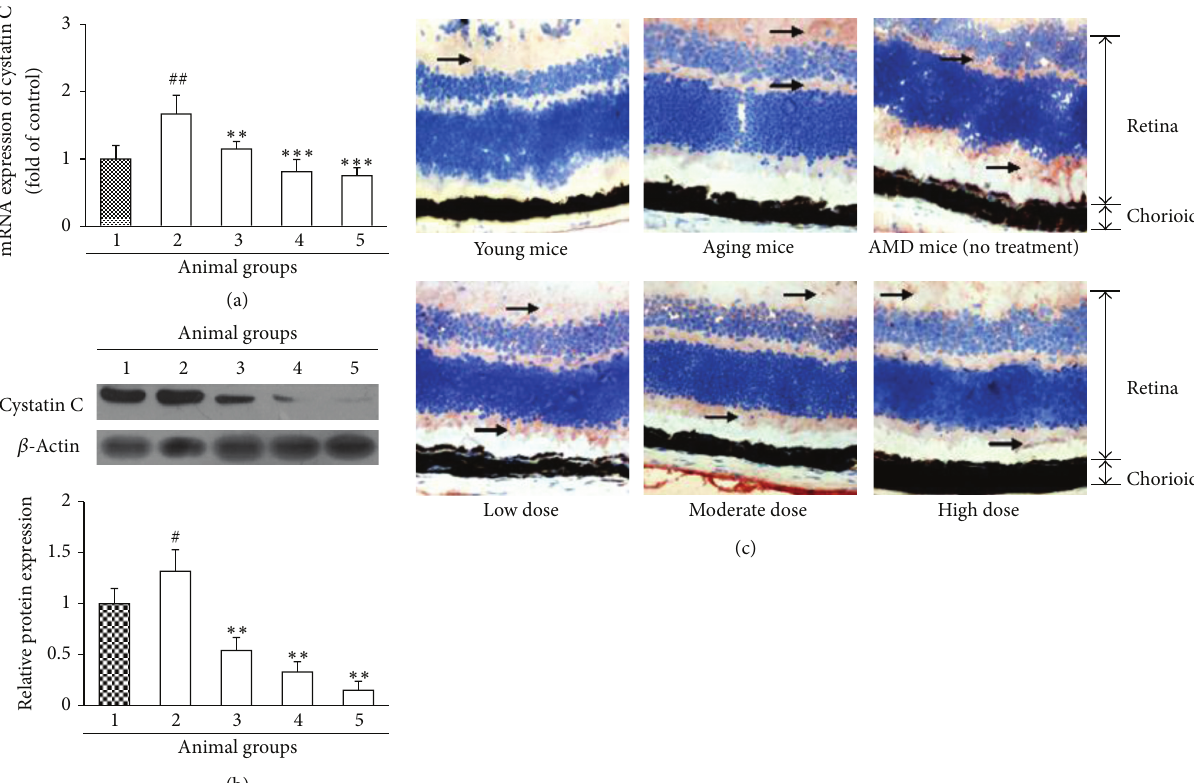
Figure 3: Effects of Fructus lycii ethanol extract on cystatin C expression in mice with an experimental model of AMD. Mice were grouped: group 1, aging control group (no high-fat diet plus hydroquinone, no treatment); group 2, AMD model group (with high-fat diet plus hydroquinone, no treatment); group 3, low dose group (with high-fat diet plus hydroquinone, 1.25g/kg treatment); group 4, moderate dose group (with high-fat diet plus hydroquinone, 2.50 g/kg treatment); and group 5, high dose group (with high-fat diet plus hydroquinone, 3.75 g/kg treatment). (a) Real-time PCR analysis for transcript level of cystatin C. GAPDH was used as the invariant control for calculating fold changes in mRNA levels ( 𝑛 = 10 ). Data are expressed as mean ± SD, # 𝑃 < 0.01 versus group 1, ∗∗ 𝑃 < 0.01 versus group 2, and ∗∗∗ 𝑃 < 0.001 versus group 2. (b) Western blot analysis for protein level of cystatin C. 𝛽 -Actin was used as an invariant control for equal loading. Representative blots were from 10 independent experiments with quantification. Data are expressed as mean ± SD, ∗∗ 𝑃 < 0.01 versus group 2. (c) Immunohistochemical staining of the eye tissues for cystatin C was detected in different groups (magnification × 25000). Normal young mice (3 months old) were used as negative control. The retina and chorioid are